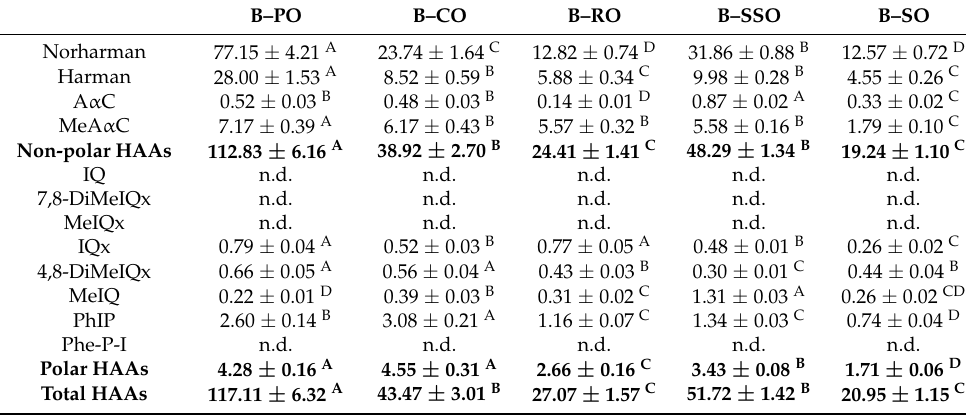
Table 3. The HAA content (ng/g) in different vegetable oil after frying.